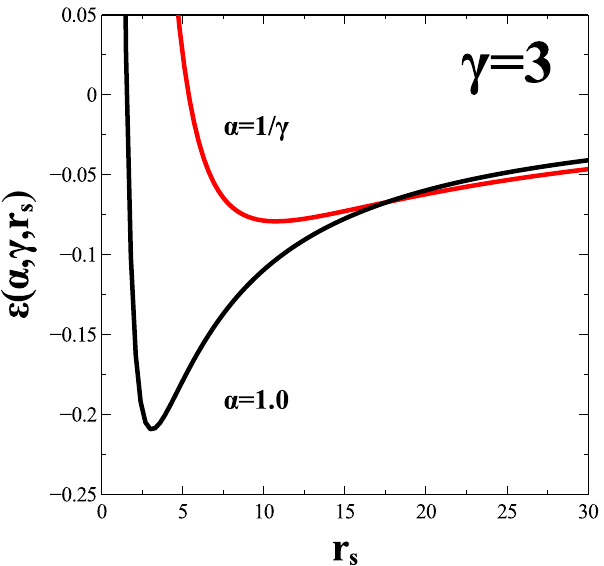
1 and α 1 /γ , namely, ǫ(α 1, γ , r s ) and Figure 1. Total energy per particle for the cases of α = = = 1 /γ , γ , r s ) as a function of r s corresponding to a spinless 2DEG system with anisotropic Coulomb ǫ(α = 3 . The energy is measured in units of k e e 2 interaction potential with γ 2 a B . Note that a 2D Wigner crystal state = forms at values r s > 34 (see Pg. 53 of Ref. [22]). This means that the interval of r s values chosen for the current calculations is suitably restricted to densities where the Wigner lattice is not yet